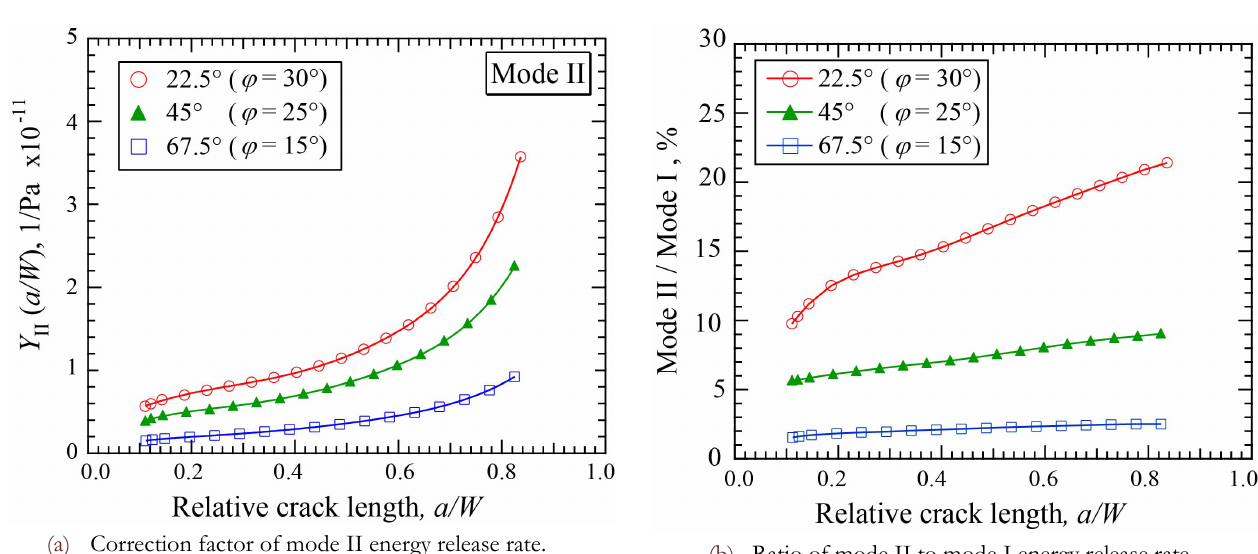
rate.(a) Correction factor of mode II energy release rate. (b) Ratio of mode II to mode I energy release Figure 11: Correction factor of mode II energy release rate and ratio of mode II/mode energy release